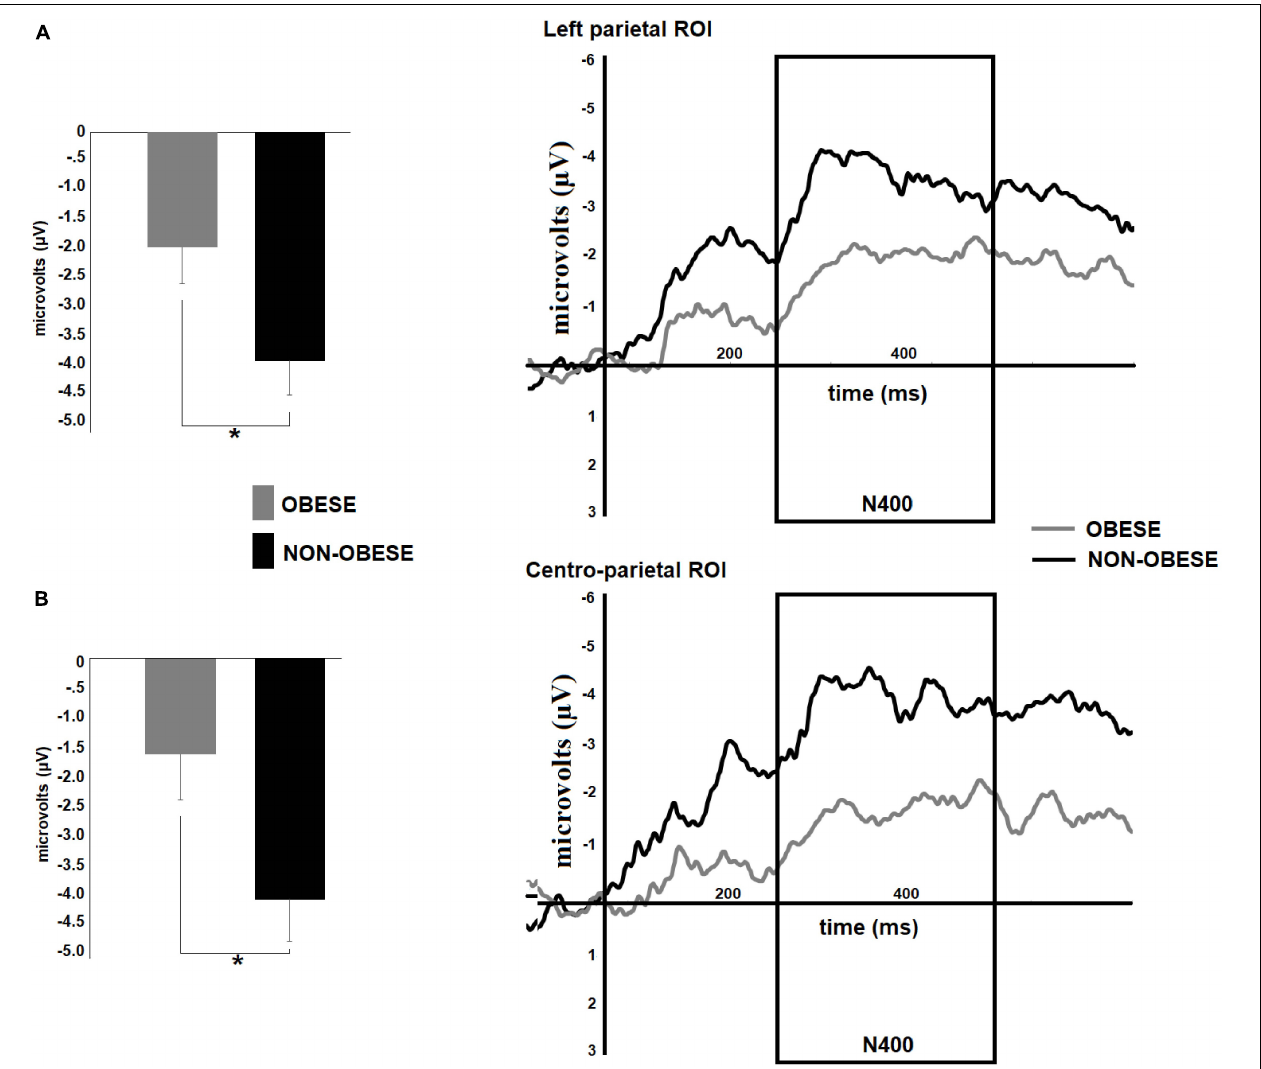
FIGURE 5 | Differences between obese and no-obese preteens with low math skills in arithmetic N400 amplitude. Right panels show the mean amplitude maps of the arithmetic N400 component in left parietal and centro-parietal regions for both weight groups during subtraction condition. The bar graphs (A,B) illustrate the differences between groups in arithmetic N400 amplitude in each region of interest: (A) left parietal, and (B) centro-parietal ROIs. A greater N400 amplitude was observed for non-obese participants. Significant p -values were represented as follows: * p <